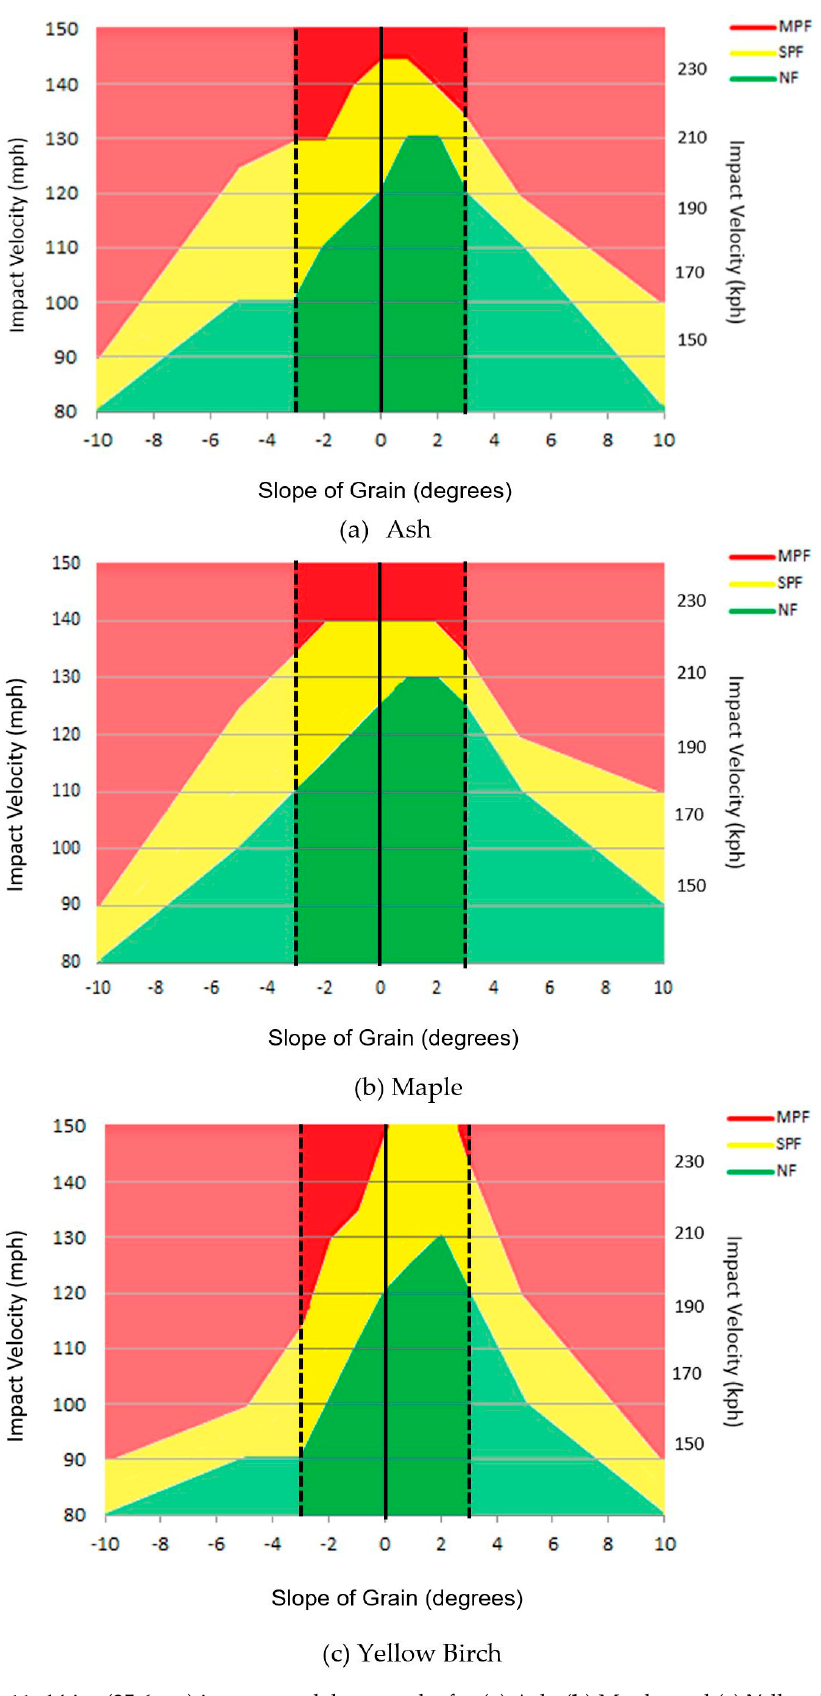
Figure 11. 14 in. (35.6 cm) impact model set results for ( a ) Ash, ( b ) Maple, and ( c ) Yellow Birch.